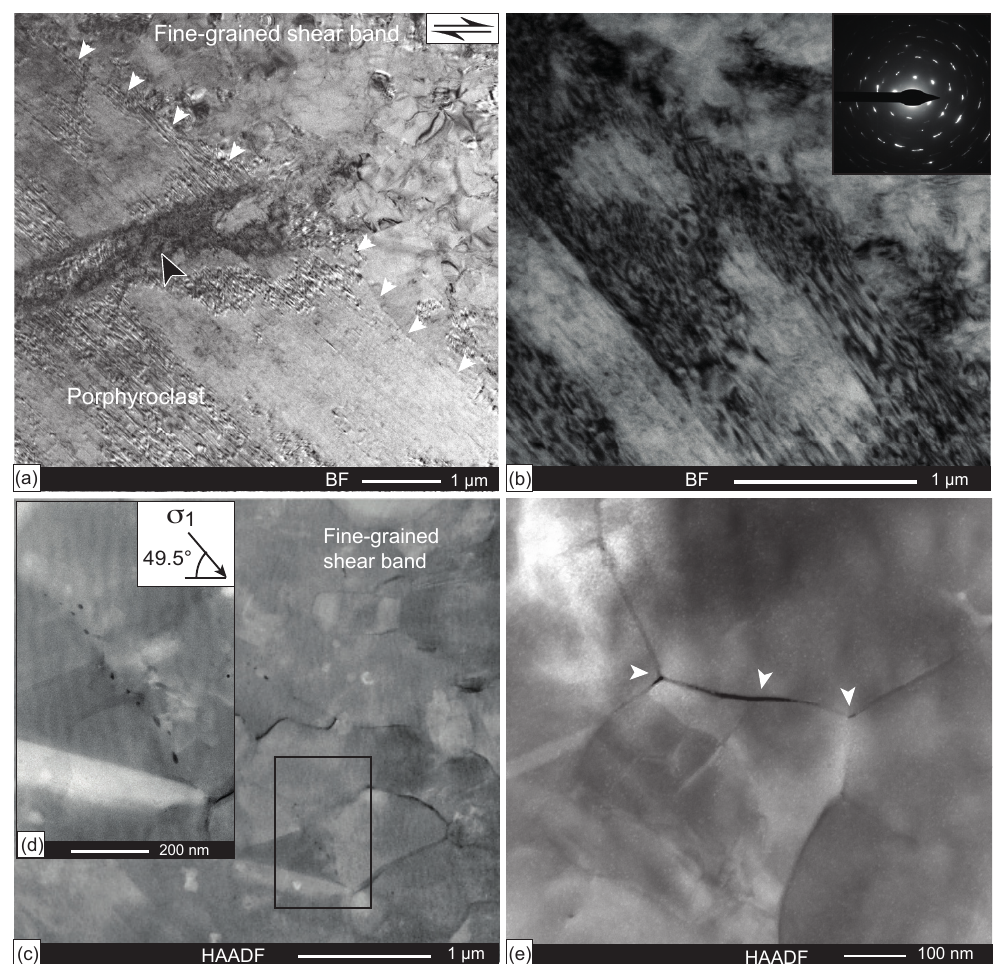
Figure 9. Nanostructures of shear bands in Ab+En sample. For sample 518, shear zone boundaries are horizontal and shear sense is dextral. (a) Bright-field (BF) image of a plagioclase porphyroclasts adjacent to a fine-grained shear band. White arrows mark the porphyroclast– shear band interface. Black arrow points to a high defect density band within the clast. (b) BF image of the internal structure of porphyroclast showing high defect density. Twin lamellae run from the upper left to lower right. (c) HAADF image of a fine-grained plagioclase in a shear band. Black rectangle marks close-up view in panel (d) . (d) HAADF image of a pore trail following several aligned grain boundaries. The local orientation of σ 1 is derived from the orientation of the ISA (Table 2). (e) HAADF image. White arrows point to porosity or opening sites developed along two triple junctions and a grain